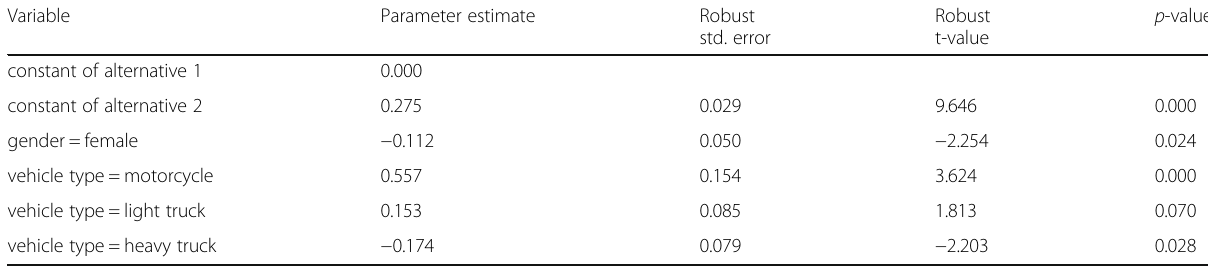
Table 3 Binomial logit model of “ not responsible drivers ” (alternative 1 = reference) and “ mainly responsible drivers ” (alternative 2); sample = all drivers with specified responsibility involved in a motorway crash; predictors = vehicle type and gender (reference vehicle type = car; reference gender = male)